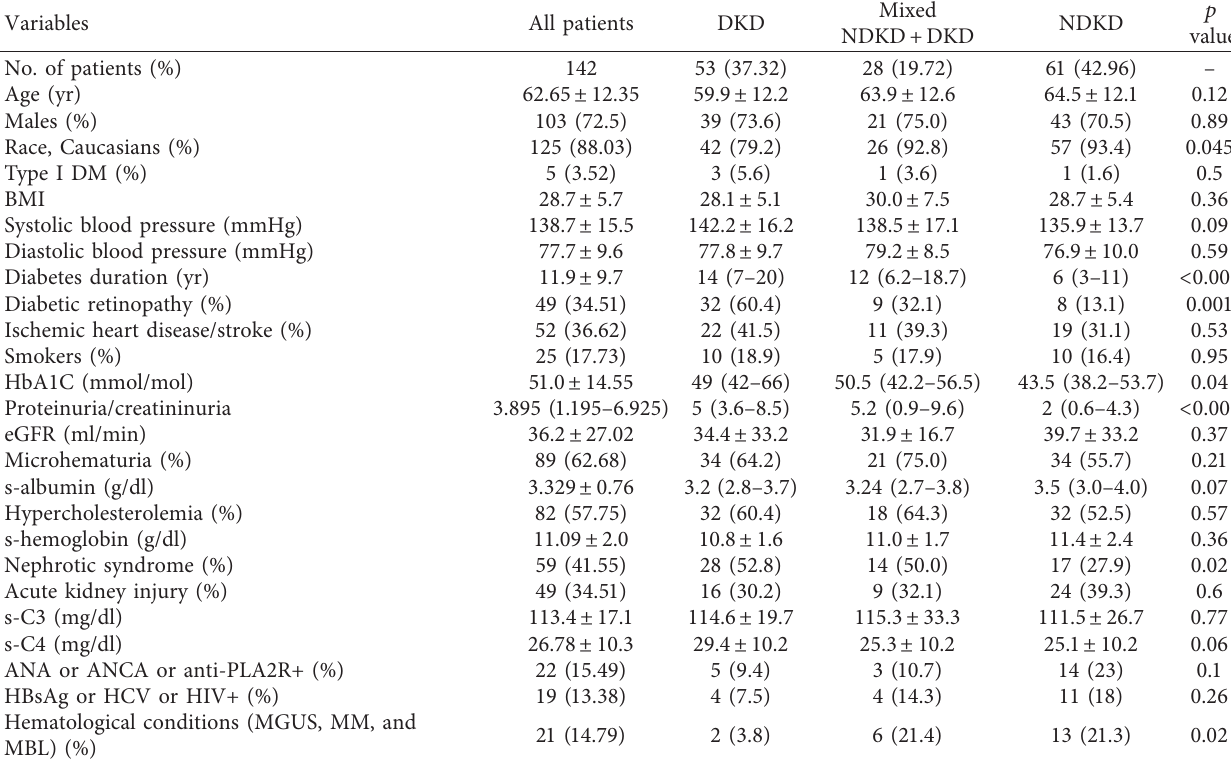
Table 1: Clinical and laboratory characteristics of patients with DKD, NDKD, and mixed NDKD+ DKD.